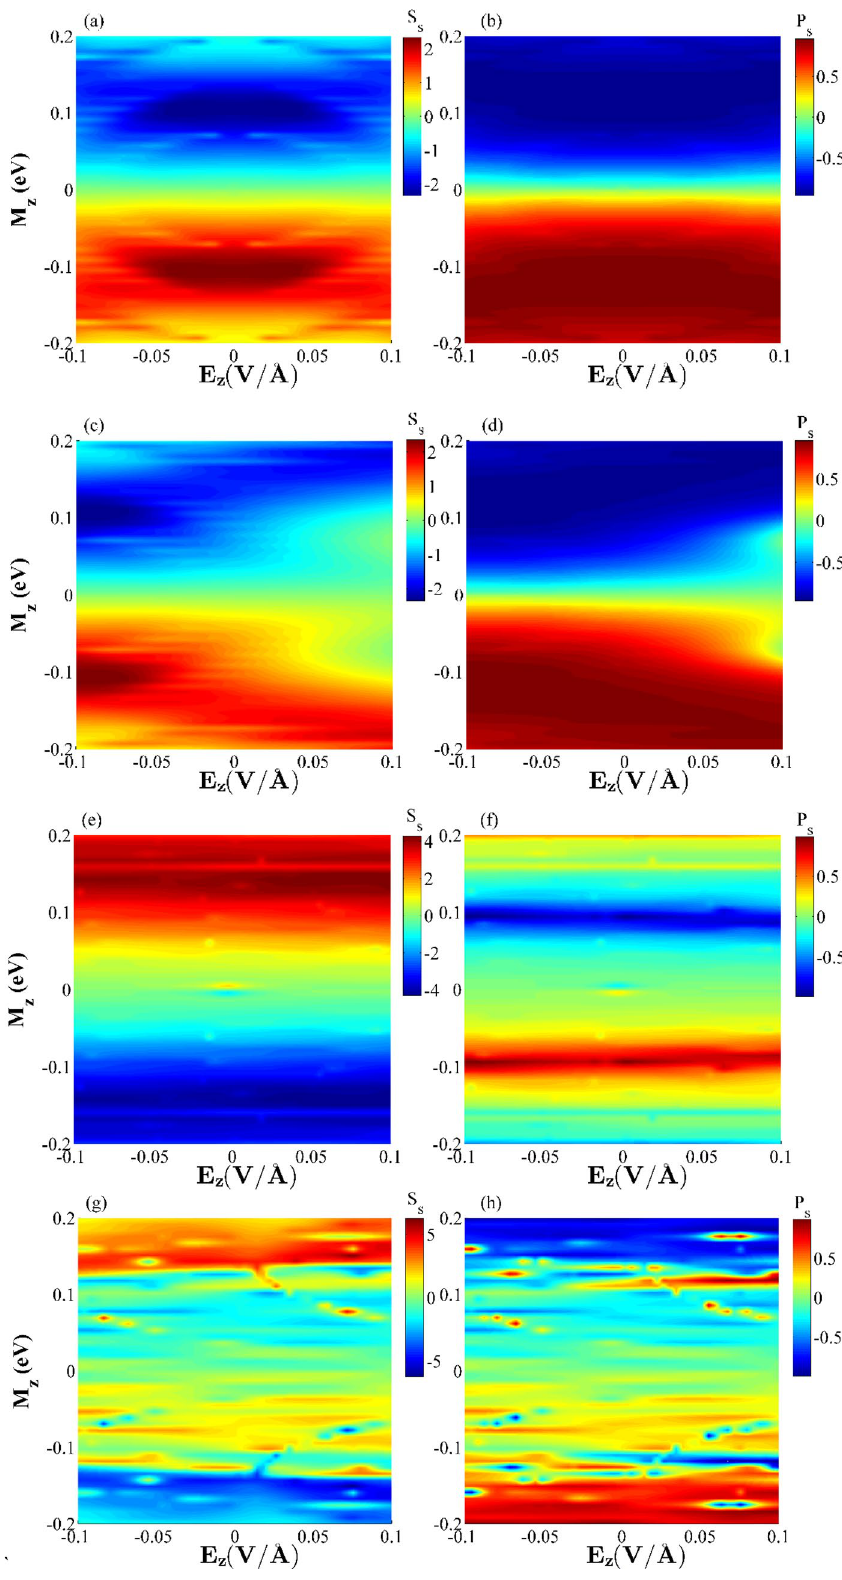
Figure 10. The combined effects of ferromagnetic exchange fields, M Z , and external electric fields ( E Z , E y G and E y S ) on the spin Seebeck coefficient ( S S ) and Seebeck polarization ( P S ) for the considered hybrid GSN R and ( a , b ) E y G = E y S = 0 ( c , d ) E y G = E y S = 0.001 V/Å ( e , f ) E y G = 0.913 V/Å, E y S = 0.127 V/Å ( g , h ) E y G = 0.029 V/Å, E y S = 0.575 V/Å. The scale of spin Seebeck coefficients in all plots is k B /e